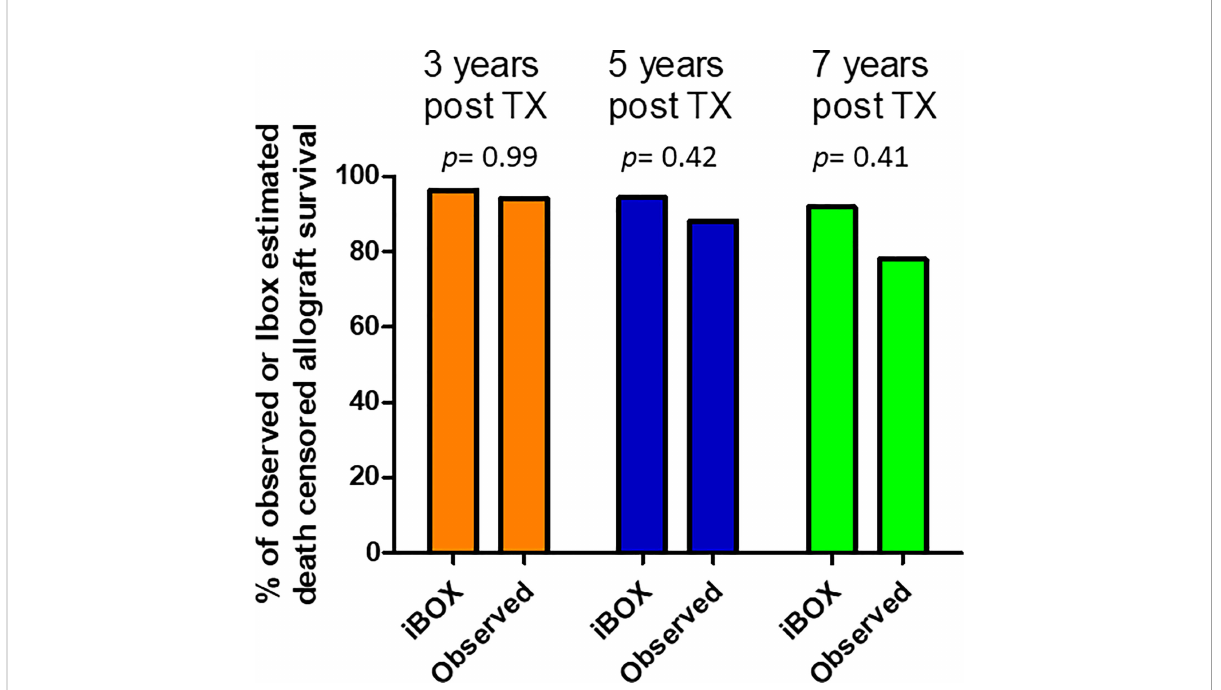
FIGURE 3 Comparison of Ibox predicted and observed death censored allograft survival at years 3, 5 and 7 post transplantation. The obtained mean iBOX score at each time post transplantation was compared with the observed graft